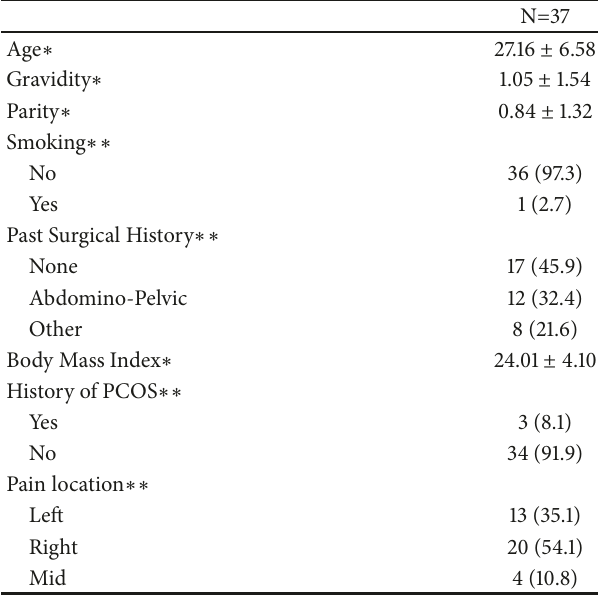
Table 1: Patient